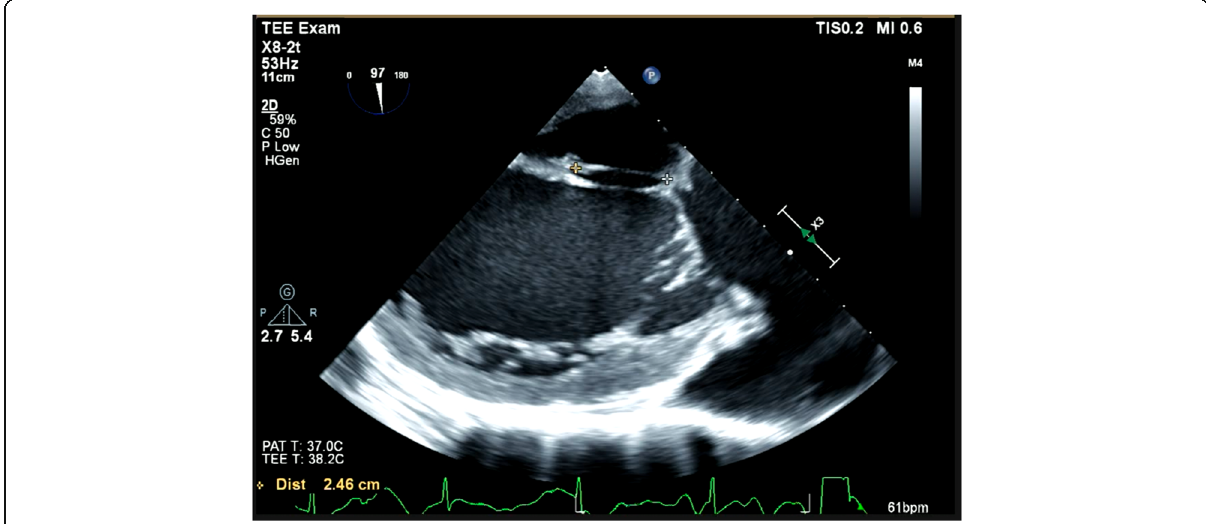
Fig. 2 Two-dimensional, transgastric, two-chamber view to determine the optimal artificial chordae length. The optimal length of the artificial chordae was defined as equivalent to the length of the native secondary chordae adjacent to the prolapse site